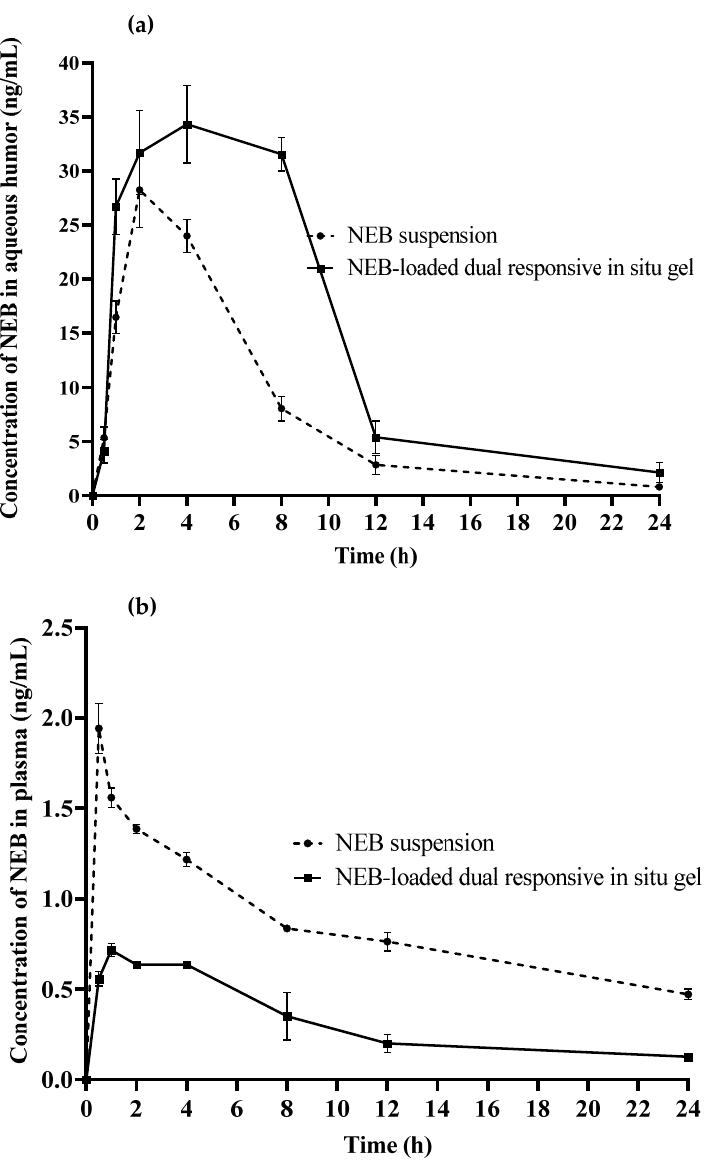
Figure 10. Mean concentration versus time profiles obtained following ocular administration of NEB suspension and optimized NEB in-situ gel in male New Zealand white rabbits ( a ) in aqueous humor and ( b ) in plasma. Each data point represents the mean of four independent determinations ( n = 4). The aqueous humor C max (35.14 ± 2.25 ng/mL) and AUC 0– ∞ (381.8 ± 18.32 ng/mL*h) of the NEB-loaded dual-responsive in situ gel were 1.2 fold ( P cal < 0.05) and 2 fold ( P cal < 0.0001) higher as compared with the C max (28.2 ± 3.1 ng/mL) and AUC 0– ∞ (194.9 ± 12.17 ng/mL*h)